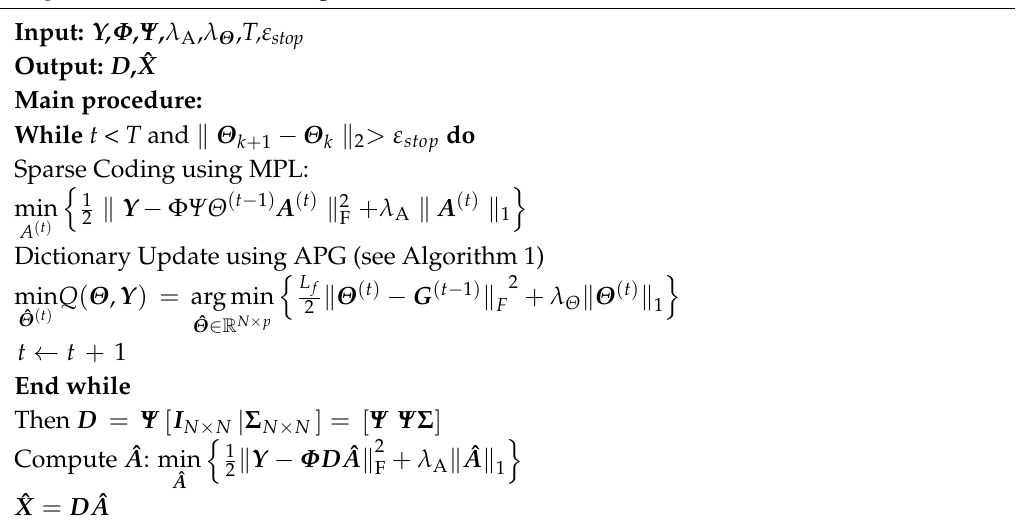
Algorithm 2. ODL-CDG